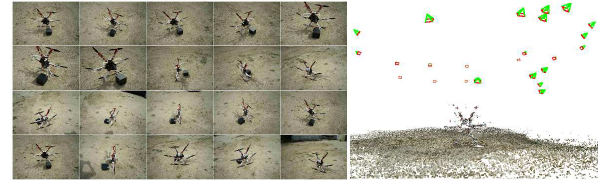
Figure 9: Photogrammetric acquisition around UAV before take- off (left) and images geometry acquisition (right) To calculate the lever-arm offset value only image measurements are needed. Let N be the number of targets measured on the cam- ′ era and N the number of targets measured on the GPS receiver.